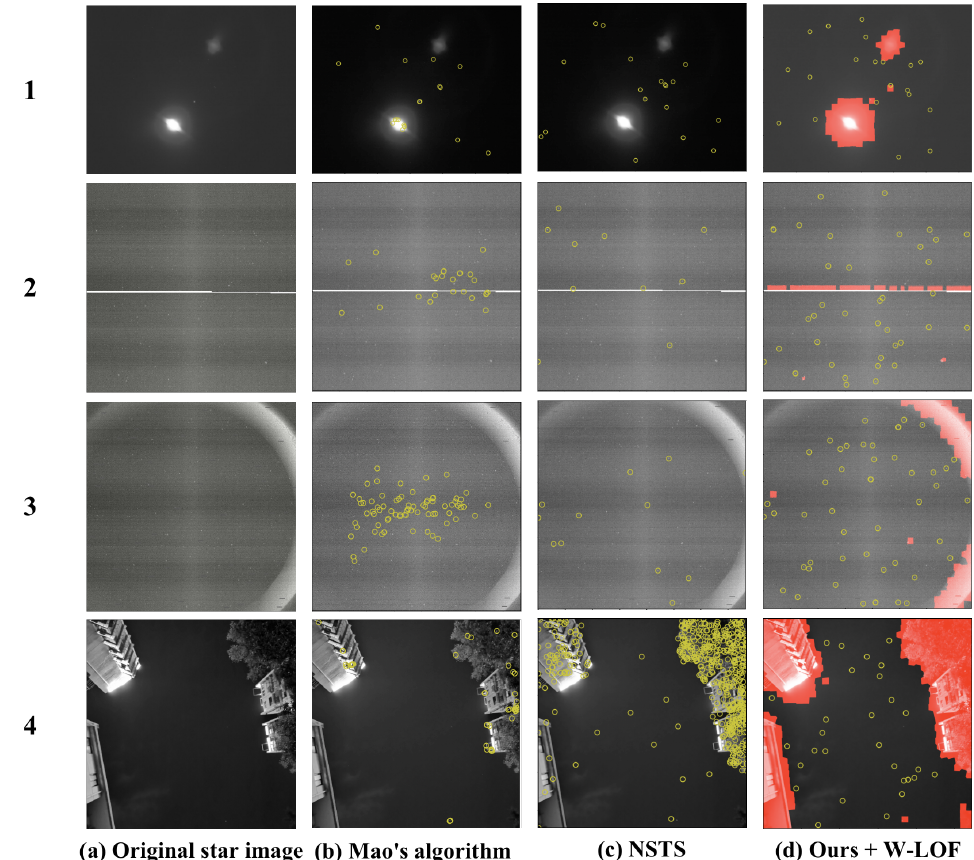
Figure 11. Result of star spot extraction with different algorithm: ( a ) original star image with different interferences; ( b ) potential stars using Mao’s algorithm; ( c ) potential stars using NSTS; and ( d ) potential stars with our method and Wavelet-LOF algorithm.